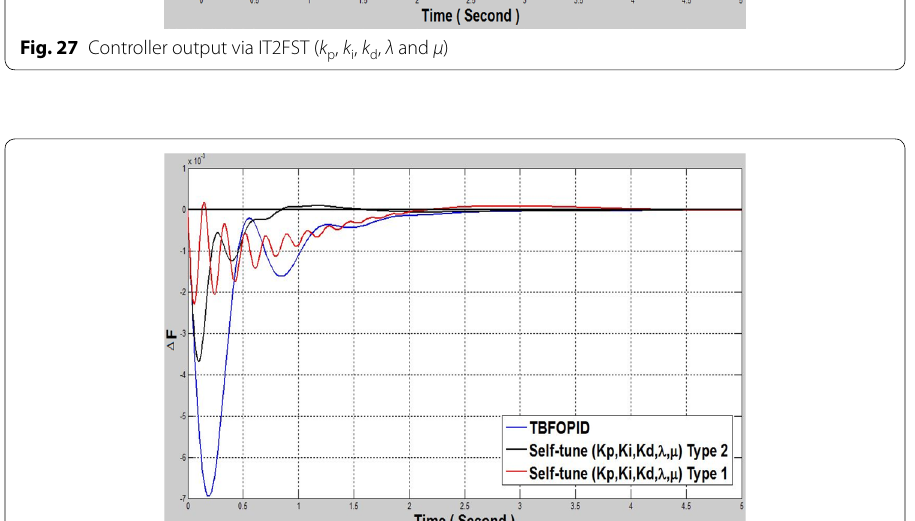
Fig. 28 Response of Δ F via IT2FST and T1FST for TSMFOPID ( k p , k i , k d , λ and μ )